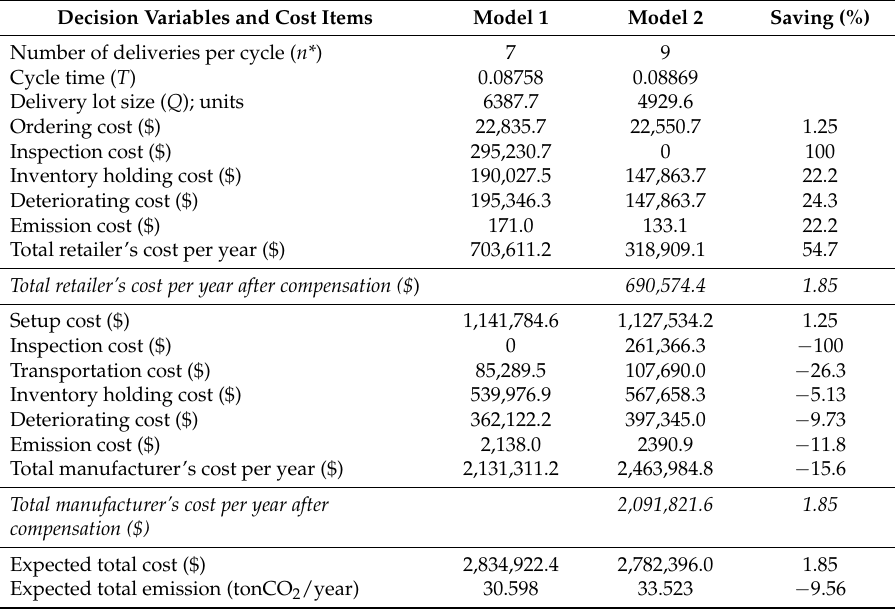
Table 5. Comparison between Model 1 and Model